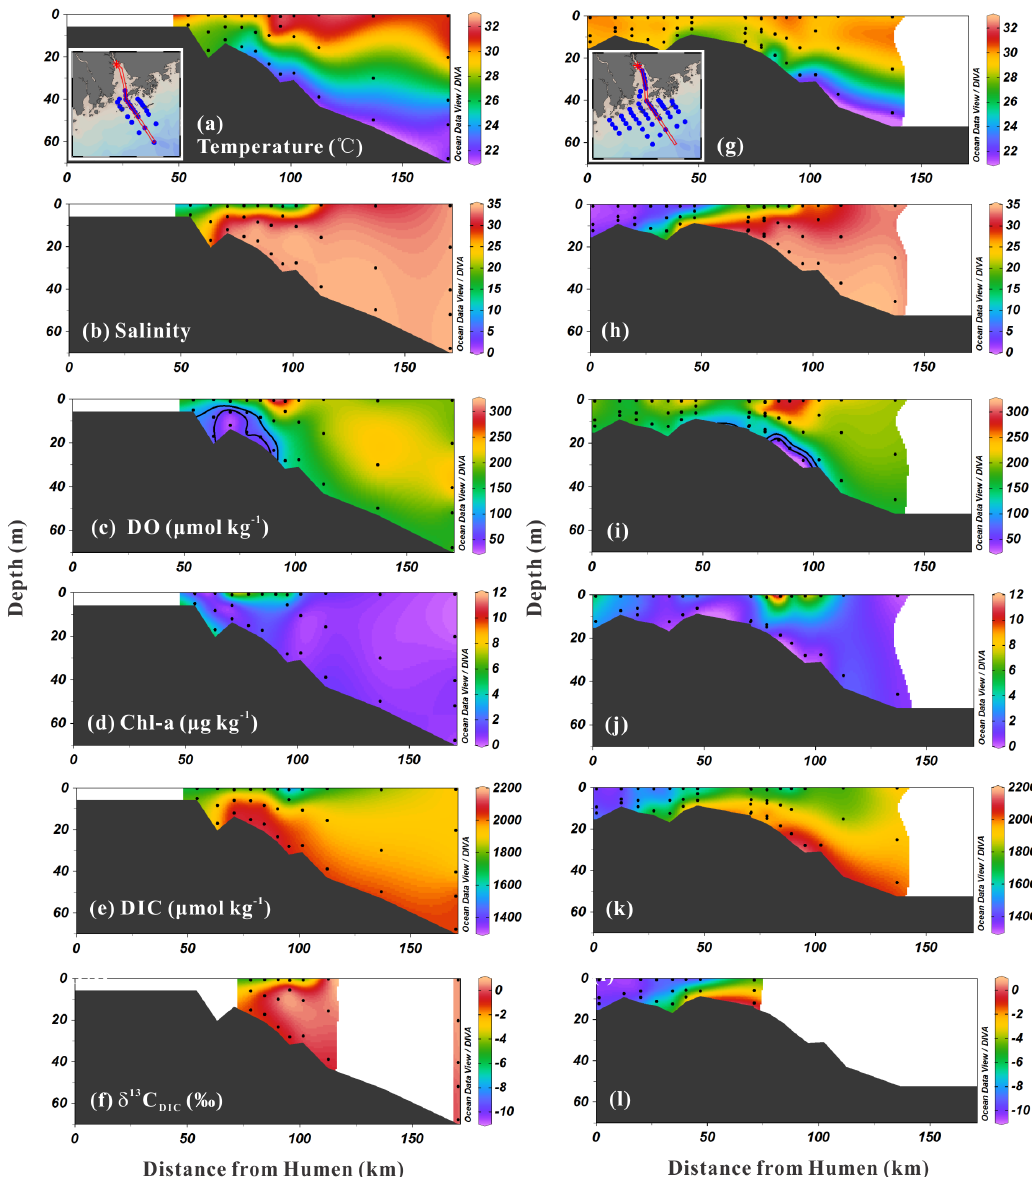
Figure 4. Profiles of temperature, salinity, DO, Chl a , DIC and δ 13 C DIC along Transect A during Leg 1 (a–f) and Leg 2 (g–l) . Note that the black lines in (c) and (i) indicate DO contours of 63 and